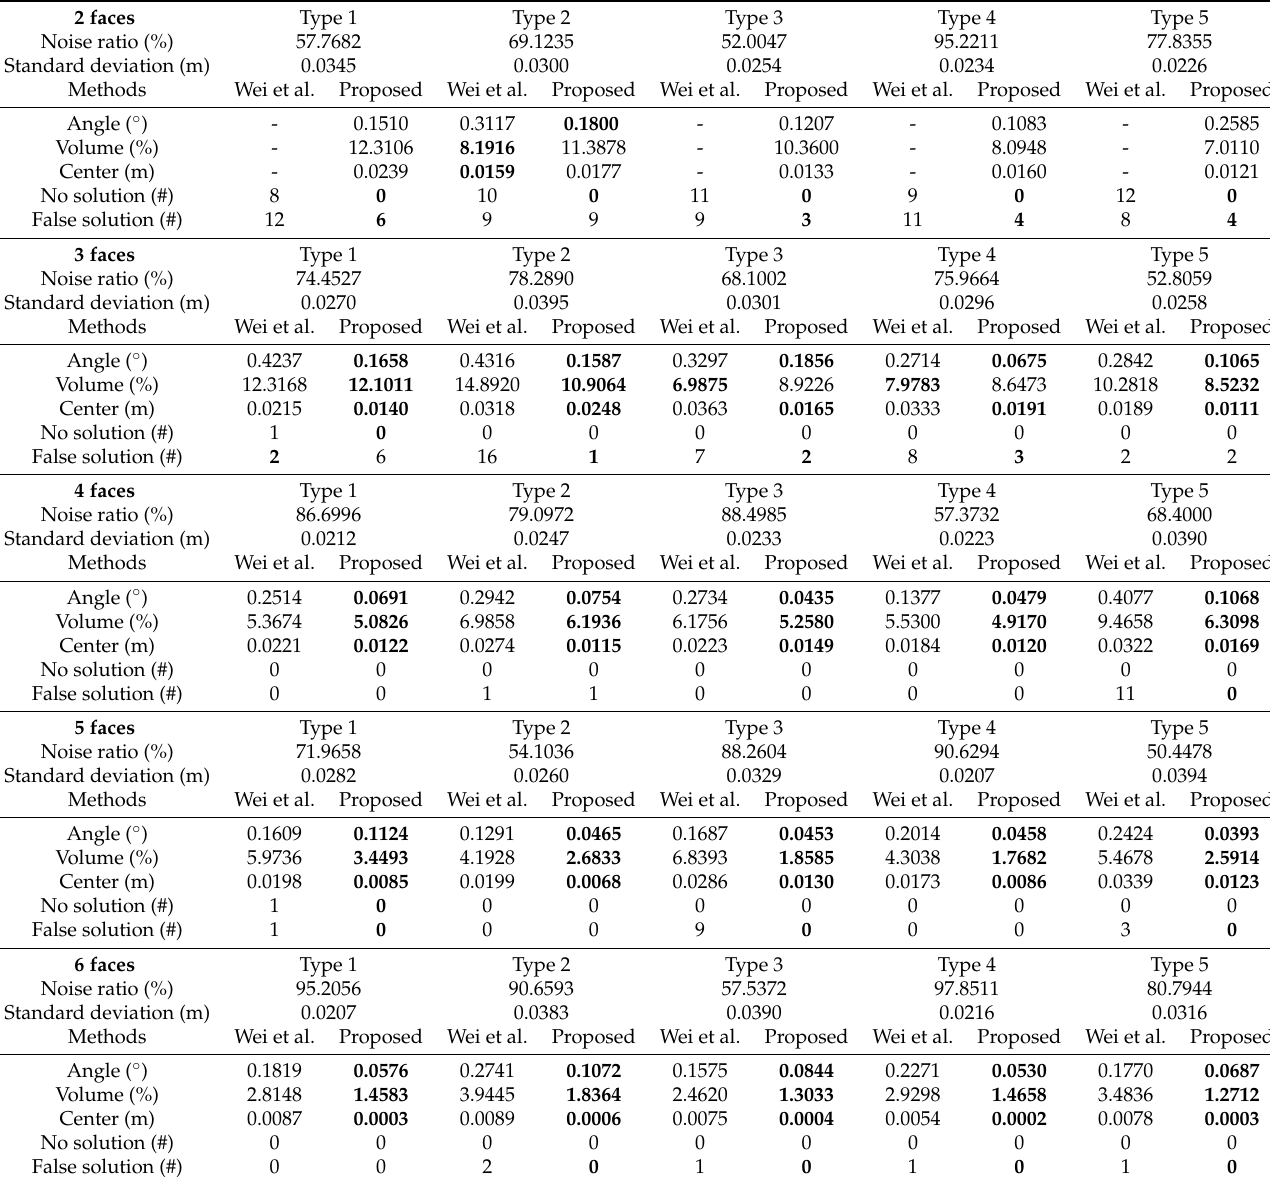
Table 2. Performance comparison depending on noise and occlusion